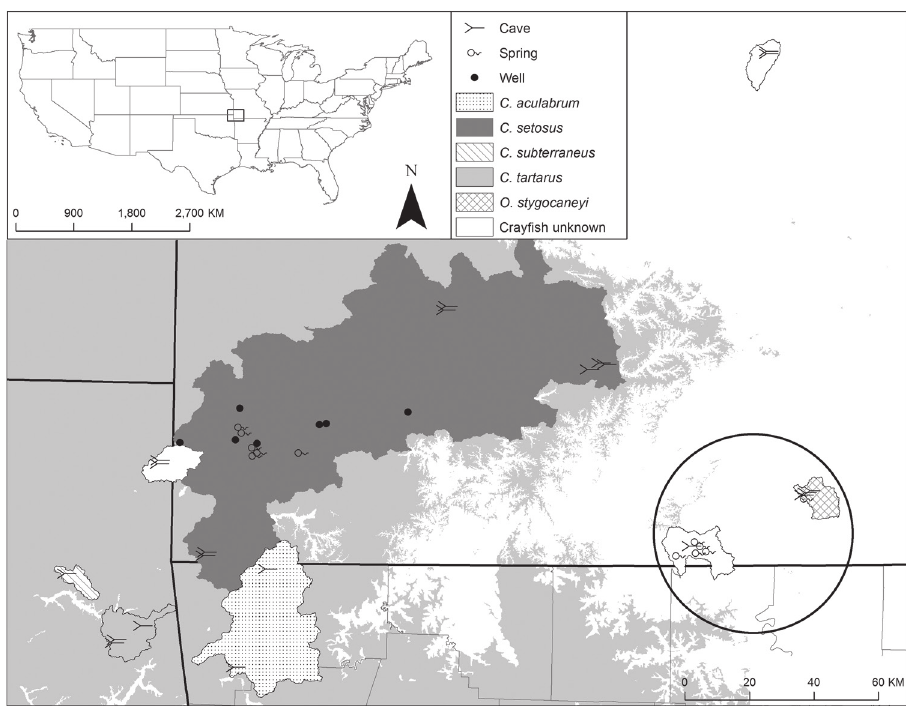
Figure 1. We conducted eDNA and visual surveys for cavefishes and cave crayfishes at 40 caves, wells, and springs across the Ozarks Highlands ecoregion. The estimated ranges of the cave crayfishes (i.e., Cambarus aculabrum , C. setosus , C. subterraneus , C. tartarus , Orconectes stygocaneyi ) are outlined using United States Geological Survey 12-digit watersheds that encompass locations where these species have been observed. Troglichthys rosae is thought to restricted to the Springfield Plateau (light-grey outline); however, we detected the species at some of the sites enclosed by the circle. Typhlichthys eigenmanni was only surveyed at our two northern-most